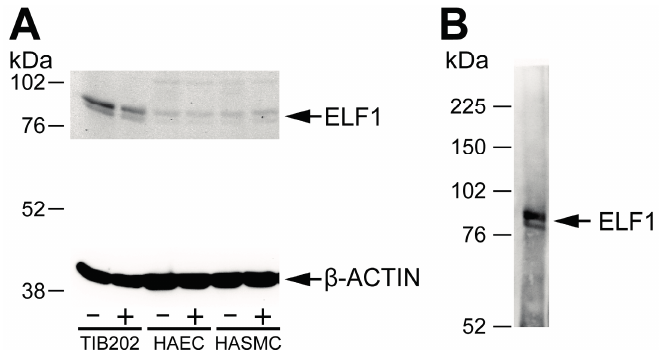
Figure 1. Western blots of ( A ) protein lysates from three different cell lines and ( B ) immunoprecipitated proteins from a macrophage cell line THP-1. ( A ) Three different human cell types (macrophage, THP-1 also called TIB202; aortic endothelial, HAEC; and